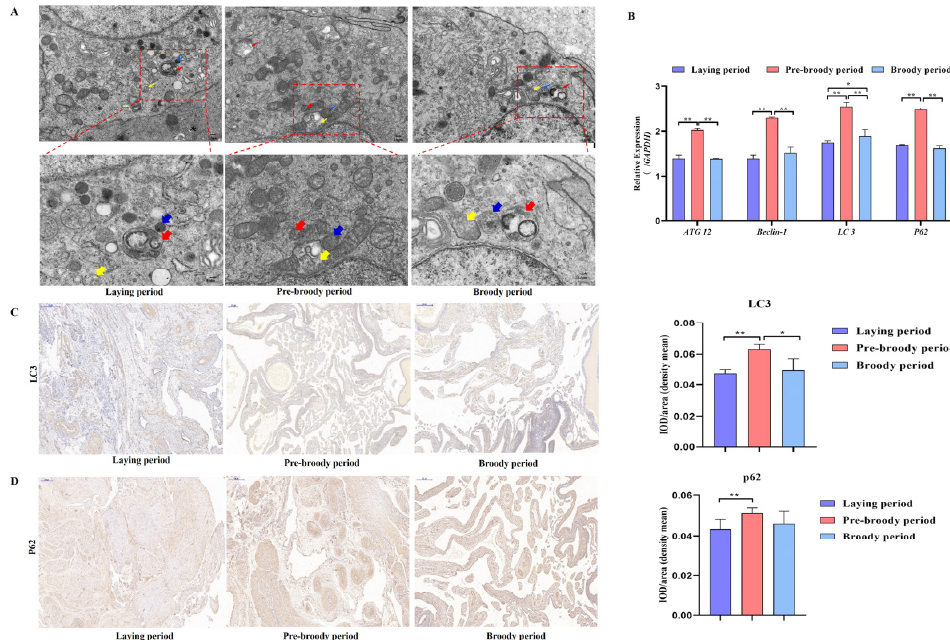
Figure 6. Changes in goose ovary autophagy during each period. ( A ) Autophagy of GCs during the laying, pre-broody and broody periods observed by electron microscopy. The areas indicated by boxes in Upper are shown at higher magnification in Lower. (Yellow arrowheads: autophagosome; Blue arrowheads: lysosome; Red arrowheads: autolysosome; Scale bars: A, Upper, 2.0 μ m; A, Lower, 1.0 μ m.) ( B ) Relative expression of ATG12 , Beclin-1 , LC3 and p62 in the ovaries of geese during different periods ( n = 3). ( C , D ) Immunohistochemical staining of LC3 and p62 . Scale bar = 200 μ m. Quantitative analysis of immunohistochemical staining of LC3 and p62 based on the mean density. All the data are expressed as the means ± standard errors of 3 independent experiments and were normalized to GAPDH ( n = 3); * p < 0.05; ** p <